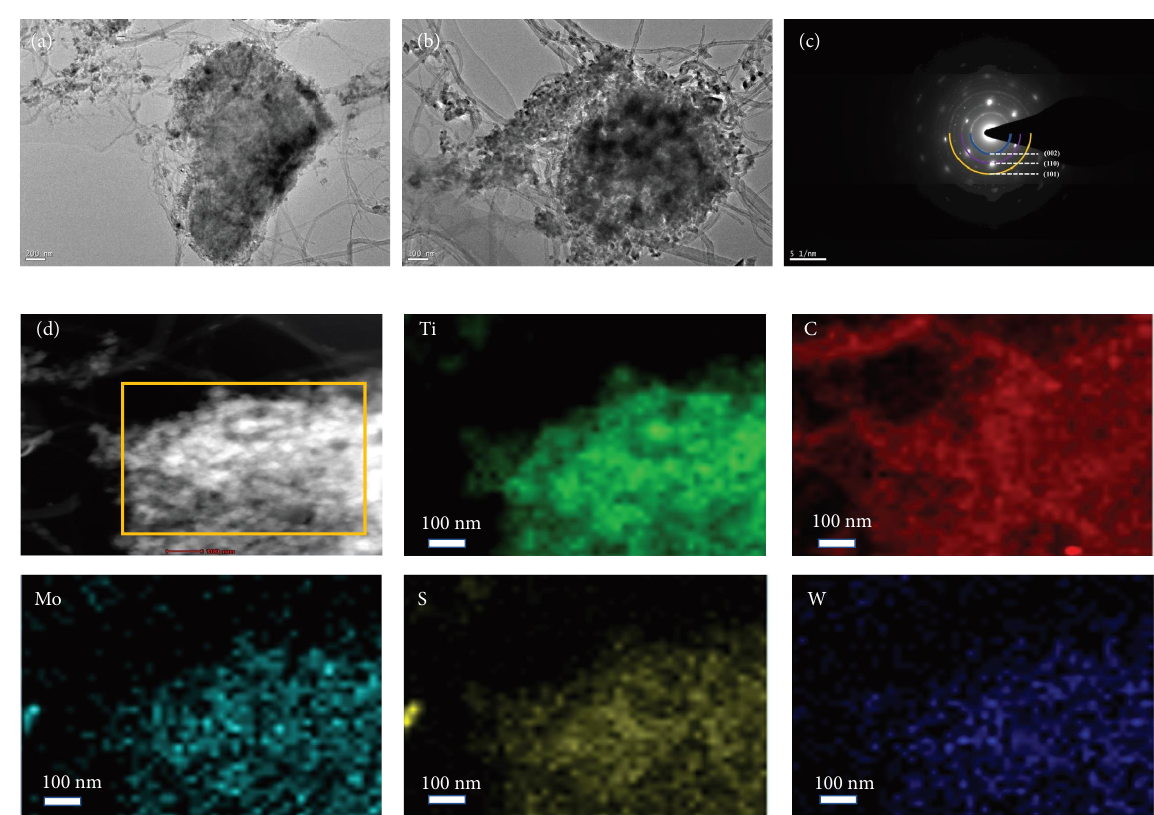
Figure 5: (a) and (b) TEM image of MoWS 2 @MXene@CNT, (c) SAED pattern of MoWS 2 @MXene@CNT, and (d) mapping of Ti, C, Mo, S, and W of MoWS 2 @MXene@CNT.